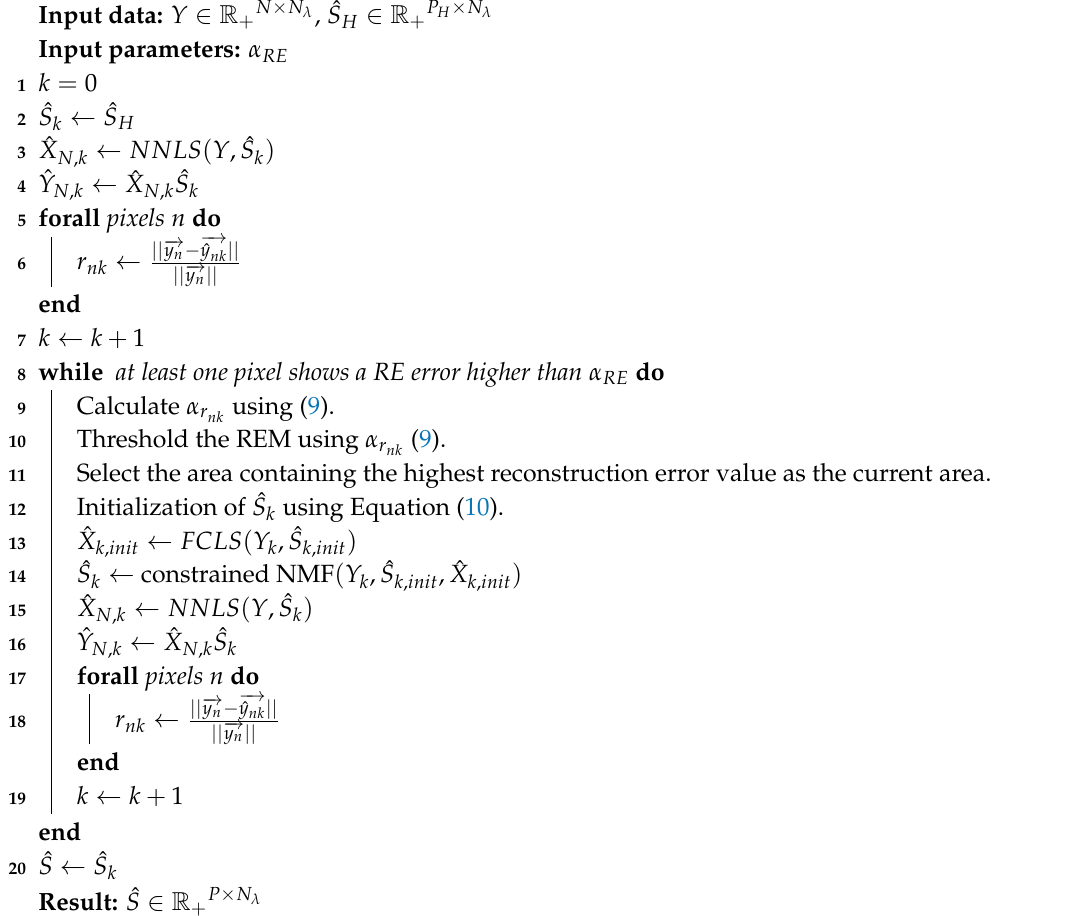
Algorithm 1: The LCNMF